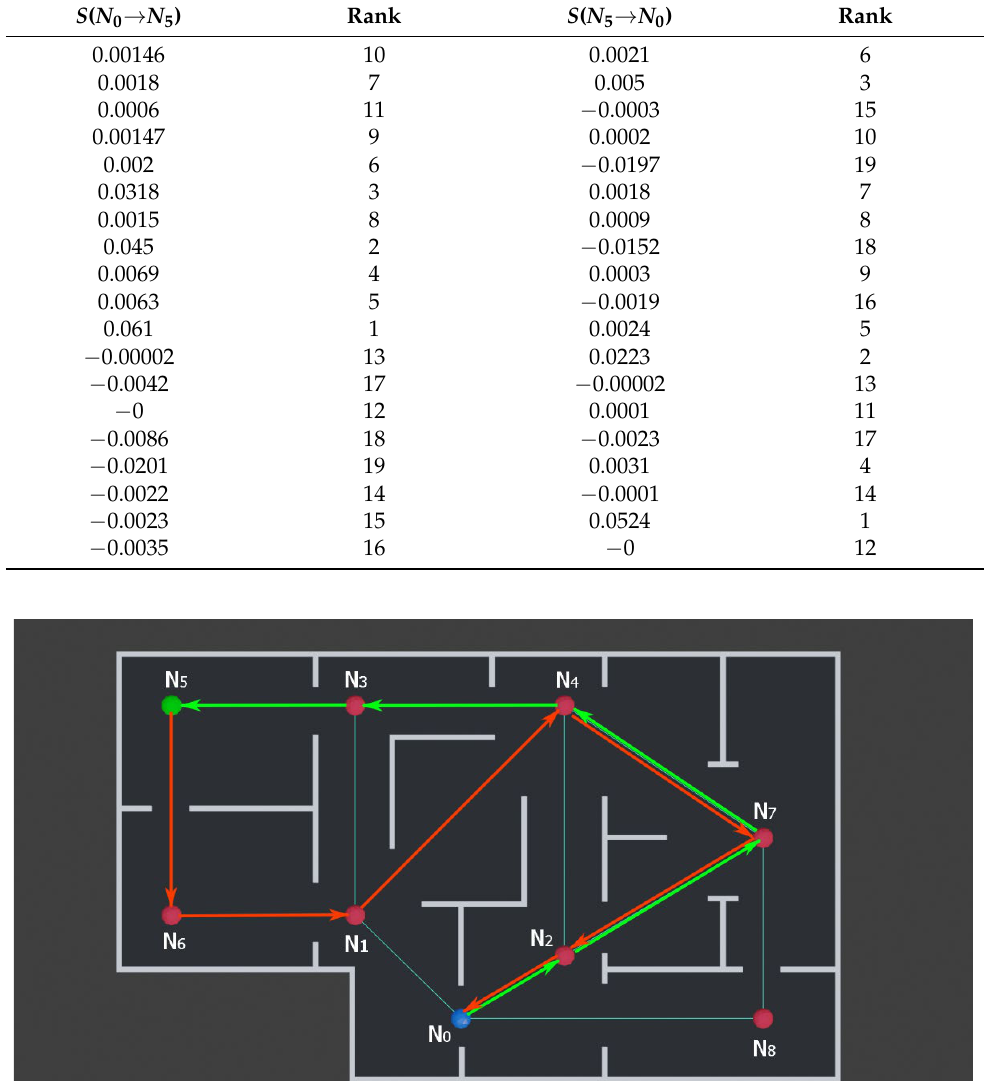
Table 5. Score values and ranks for the N 0 → N 5 and N 5 → N 0 routes obtained by applying PROMETHEE-MGQNS.